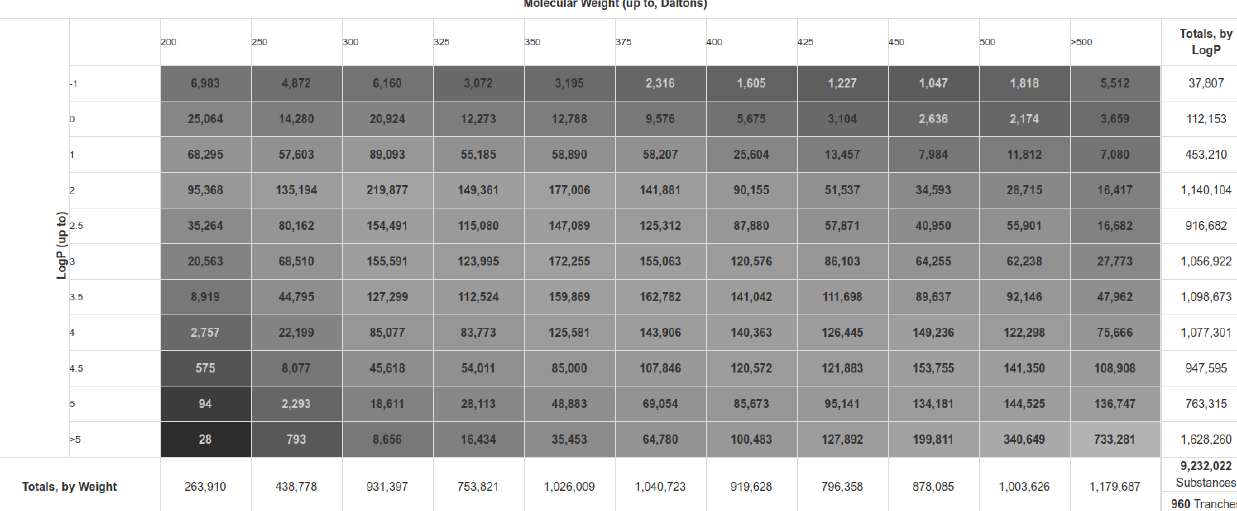
Figure 2. Detailed ZINC 15 database “ In-Stock ” subset tranche description with a total of 9,322,002 compounds used for further calculations (As obtained from the https://zinc15.docking.org; accessed on 8 May 2021; at the time of smiles compound download; the database on the master server is continuously updating ).